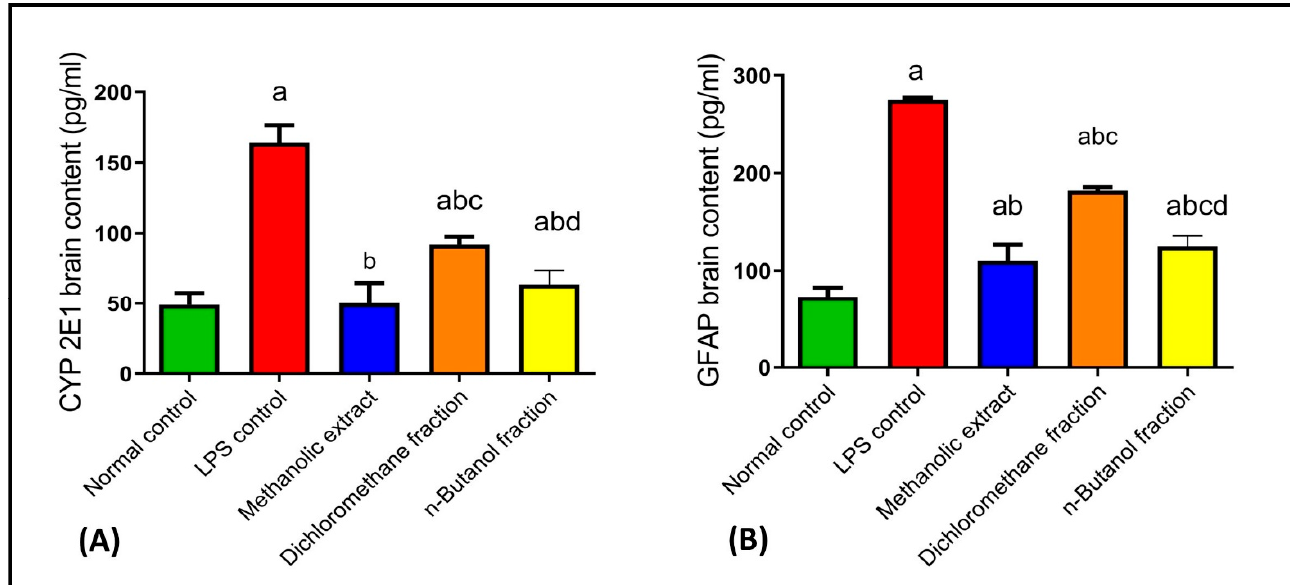
Figure 5. Effects of BME, BDMF, BBF on CYP2E1 ( A ) and GFAP ( B ) in LPS-induced Alzheimer in mice. Data are presented as the mean ± standard error (SE) of n = 8 per each group. Statistical analysis was done using one-way analysis of variance followed by Fisher’s LSD test. a Statistically significant from normal control at p < 0.05. b Statistically significant from LPS control at p < 0.05. c Statistically significant from BME at p < 0.05. d Statistically significant from BDMF at p < 0.05. BME: B. armeniaca methanolic extract; BDMF: B. armeniaca dichloromethane fraction; BBF: B. armeniaca butanol fraction; LPS: lipopolysaccharide; CYP2E1: cytochrome P450 2E1; GFAP: glial fibrillary acidic